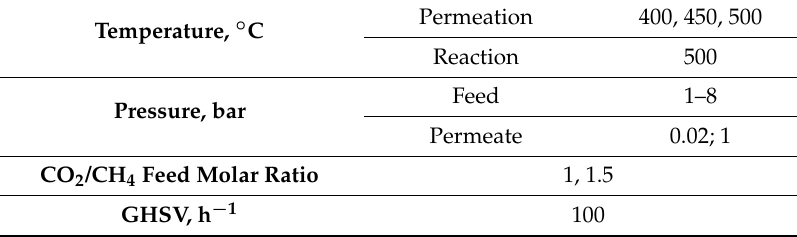
Figure 2. Sketch of the lab-scale plant for permeation and reaction experiments. Table 2. Operating conditions for experimental measurements.